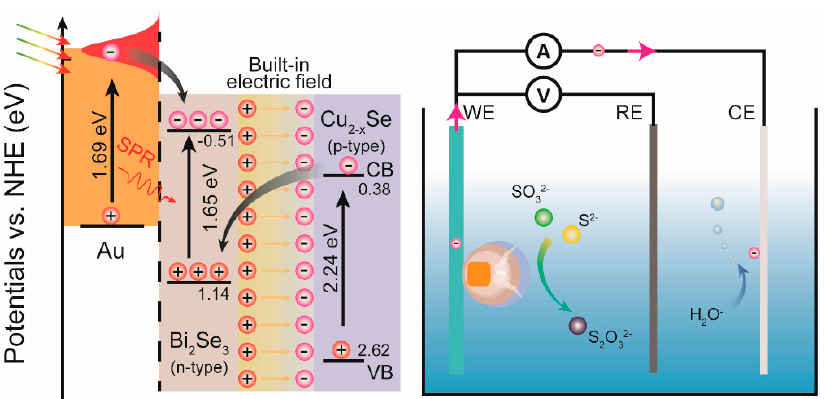
Figure 7. Schematic illustration of device configuration and proposed energy band structure of FTO photoelectrode sensitized with Au/Bi 2 Se 3 /Cu 2-x Se hybrids.